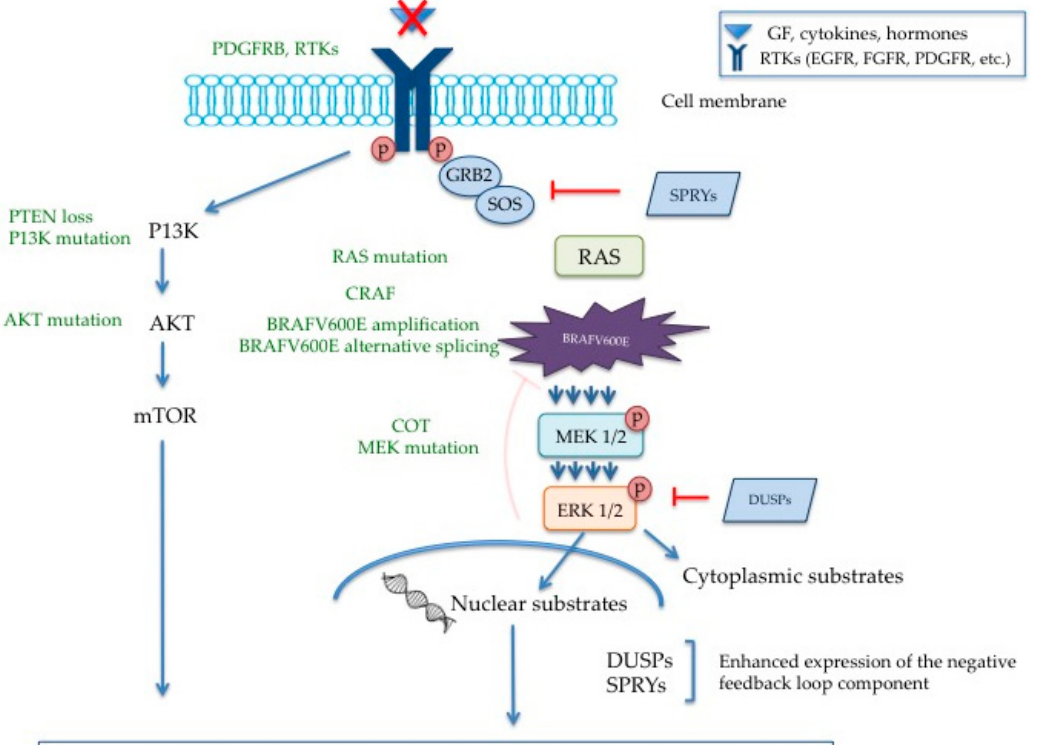
Figure 1. RAS/RAF/MEK aberrant signaling and mechanisms of resistance to inhibition in melanoma. Oncogenic BRAFV600E cells become independent from external growth factors (GF) (triangle symbol marked with a X) and other stimuli leading to constitutive activation of the MAPK pathway. Increased MAPK signalling (four arrows) eventually leads to enhanced gene expression including MAP kinase phosphatases (DUSPs) and sprouty proteins (SPRYs). Despite elevation of those important inhibitory regulators (T lines) of the MAPK pathway, tumour cells adapt and rely on neighbour pathways, such as the PI3K pathway, to grow and survive, Furthermore, negative inhibitory mechanisms of the MAPK pathway, including inactivation of BRAF via ERK1/2, are now lessened (faded T) due to conformational changes in the BRAF. Conferred mechanisms of resistance to BRAF inhibitors including up-regulation of PDGFRB, RAS mutations, elevation of CRAF, BRAFV600E amplification, alternative splicing of BRAFV600E, elevation of COT (MAP3K8), MEK mutation, PTEN loss, PI3K and AKT mutations were highlighted in green.